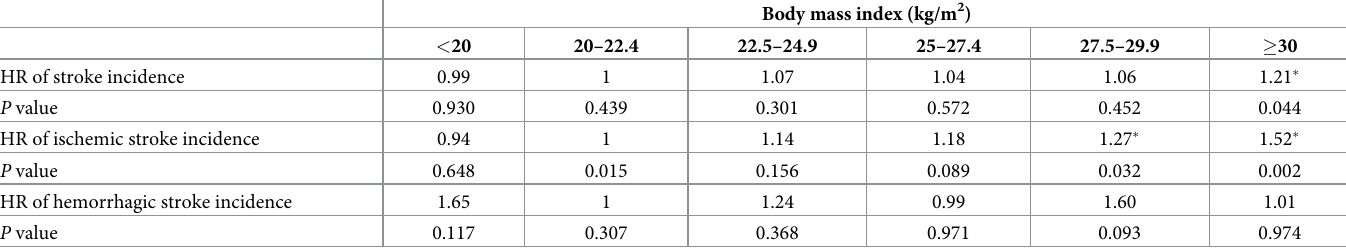
Table 5. Hazard ratios for stroke risk by different categories of body mass index among women with diabetes mellitus after excluding patients who were diagnosed with a stroke less than three years after the baseline